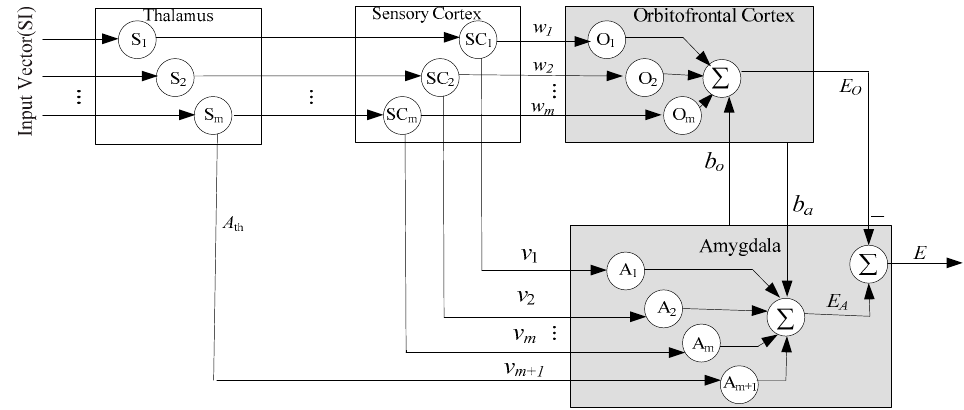
Figure 3. Improved single-output brain-inspired emotional learning (BEL) network architecture.